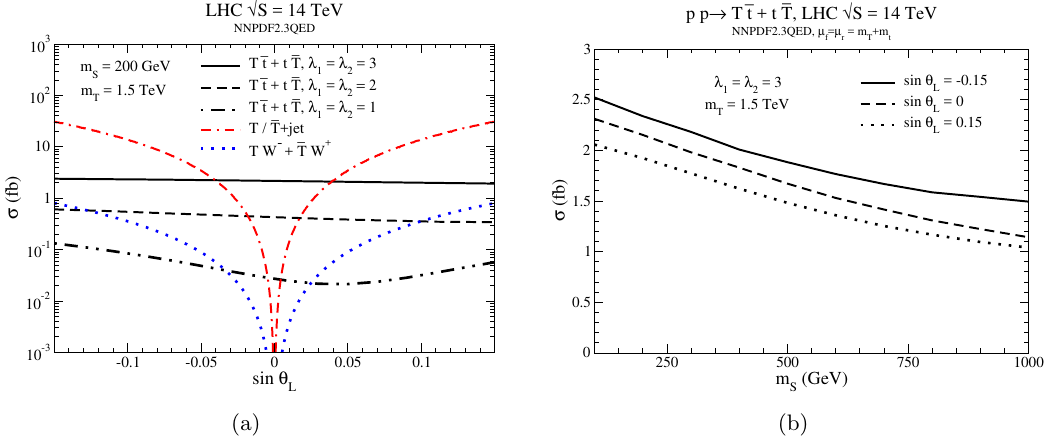
Figure 6 . (a) Production cross sections at the p S = 14 TeV LHC as a function of top partner-top mixing angle sin (cid:18) L for top partner production in association with a top quark for (black solid) (cid:21) 1 ; 2 = 3, (black dashed) (cid:21) 1 ; 2 = 2, and (black dash-dot-dot) (cid:21) 1 ; 2 = 1. Also shown are (red dash- dash-dot) top partner plus jet production and (blue dotted) top partner plus W (cid:6) production. The top partner mass is m T = 1 : 5 TeV and the scalar mass m S = 200 GeV. (b) Cross sections of top partner production in association with a top partner as a function of the scalar mass m S at the p S = 14 TeV LHC. The parameters are set at a top partner mass m T = 1 : 5 TeV, coupling constants (cid:21) 1 ; 2 = 3, and mixing angle (solid) sin (cid:18) L = 0 : 15, (dashed) sin (cid:18) L = 0, and (dotted) (cid:0) sin (cid:18) L = 0 : 15. For both (a) and (b) the factorization, (cid:22) f , and renormalization, (cid:22) r , scales are set to the sum of the (cid:12)nal state particle